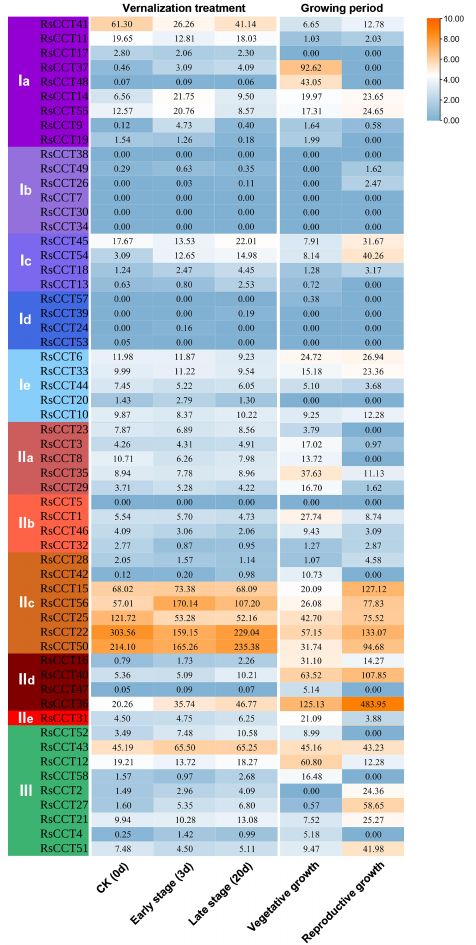
Figure 8. Expression profiles of RsCCT genes at different stages of vernalization and growing period. The heatmap was constructed based on the log2 (FPKM + 1) values of RsCCT genes. The value in the rectangle was FPKM of each RsCCT